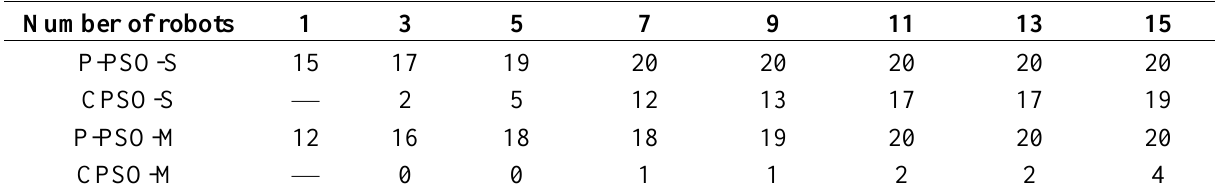
Table 1. The times of robots successfully approaching the source out of 20